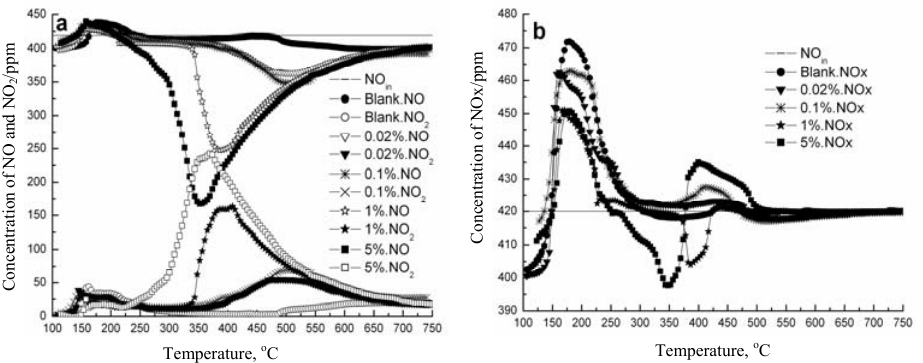
Figure 5. TPR profiles of NO, NO